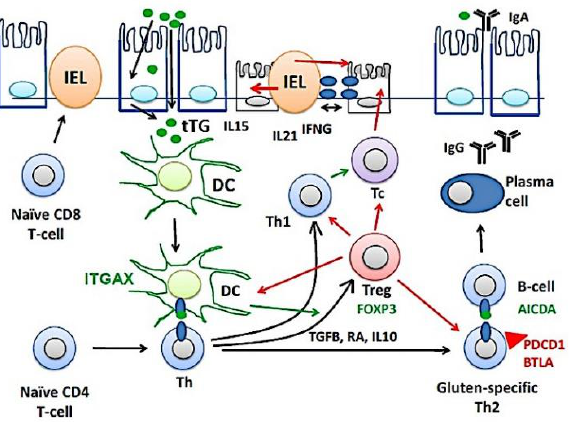
Figure 10. The pathogenesis of celiac disease. The pathogenesis of celiac disease depends on genetic susceptibility and environmental factors (dietary gluten, gliadin). An abnormal immune response in the lamina propria will lead to the chronic inflammation of the mucosa, increased intraepithelial lymphocytes (IELs), and disruption of the epithelial layer. BTLA, B and T lymphocyte associated; DC, dendritic cell; Th, T-helper lymphocyte; IFNG, interferon gamma; Tc, cytotoxic T lymphocyte; tTG, tissue transglutaminase; Treg, regulatory T lymphocyte.